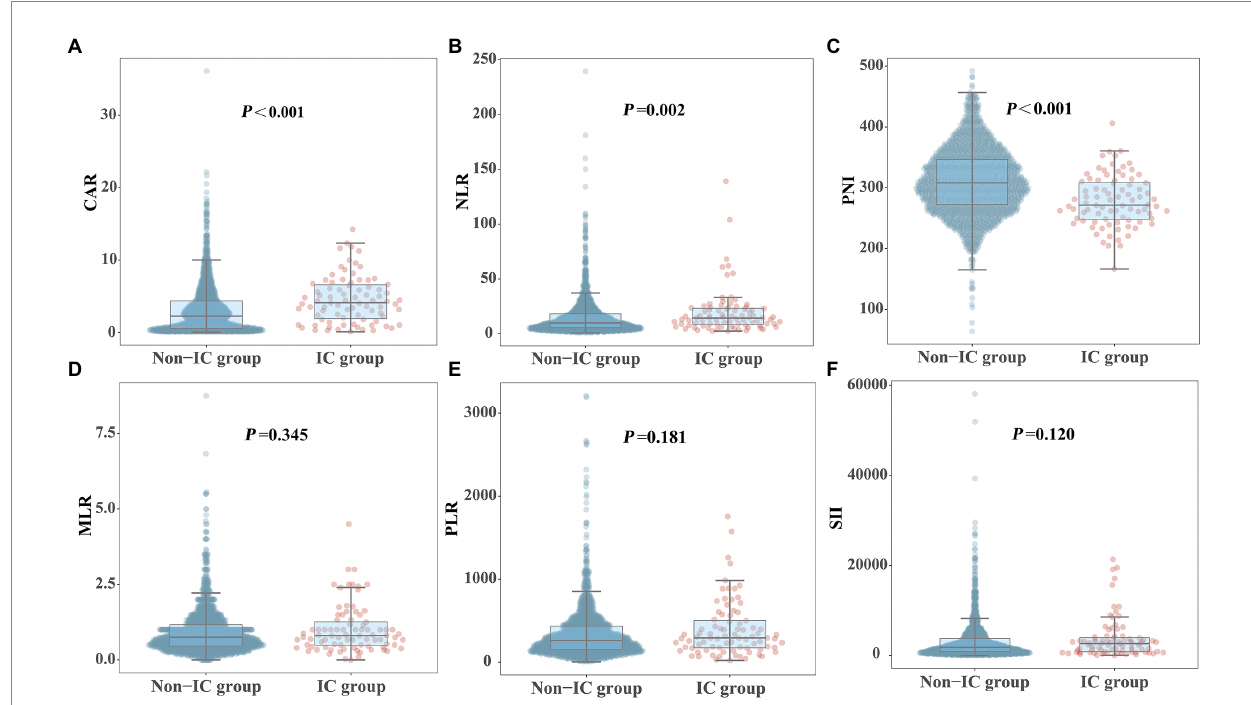
FIGURE 2 Comparison of novel serological biomarkers between IC group and non-IC group. (A) CAR, (B) NLR, (C) PNI, (D) MLR, (E) PLR, (F) SII. Data were presented as medians (IQR). Statistical significance was calculated by Mann–Whitney U test. P values indicated differences between patients in IC and non-IC group.